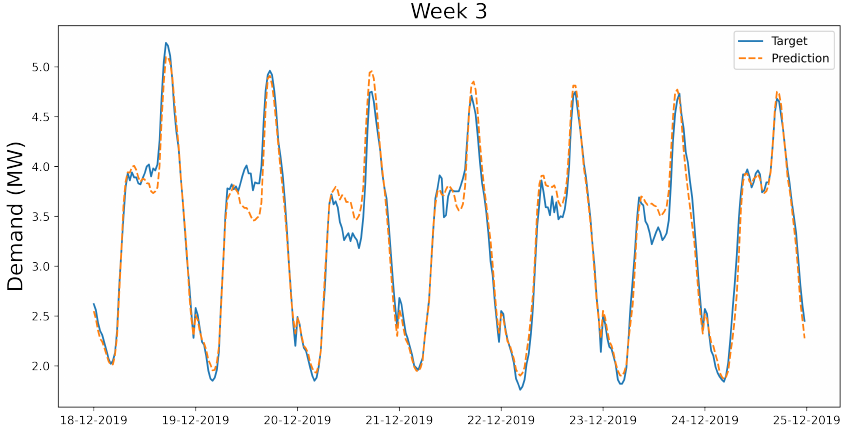
Figure 7. Comparison between the prediction and the target for week 1. The ticks in the x axis correspond to midnight for each day.